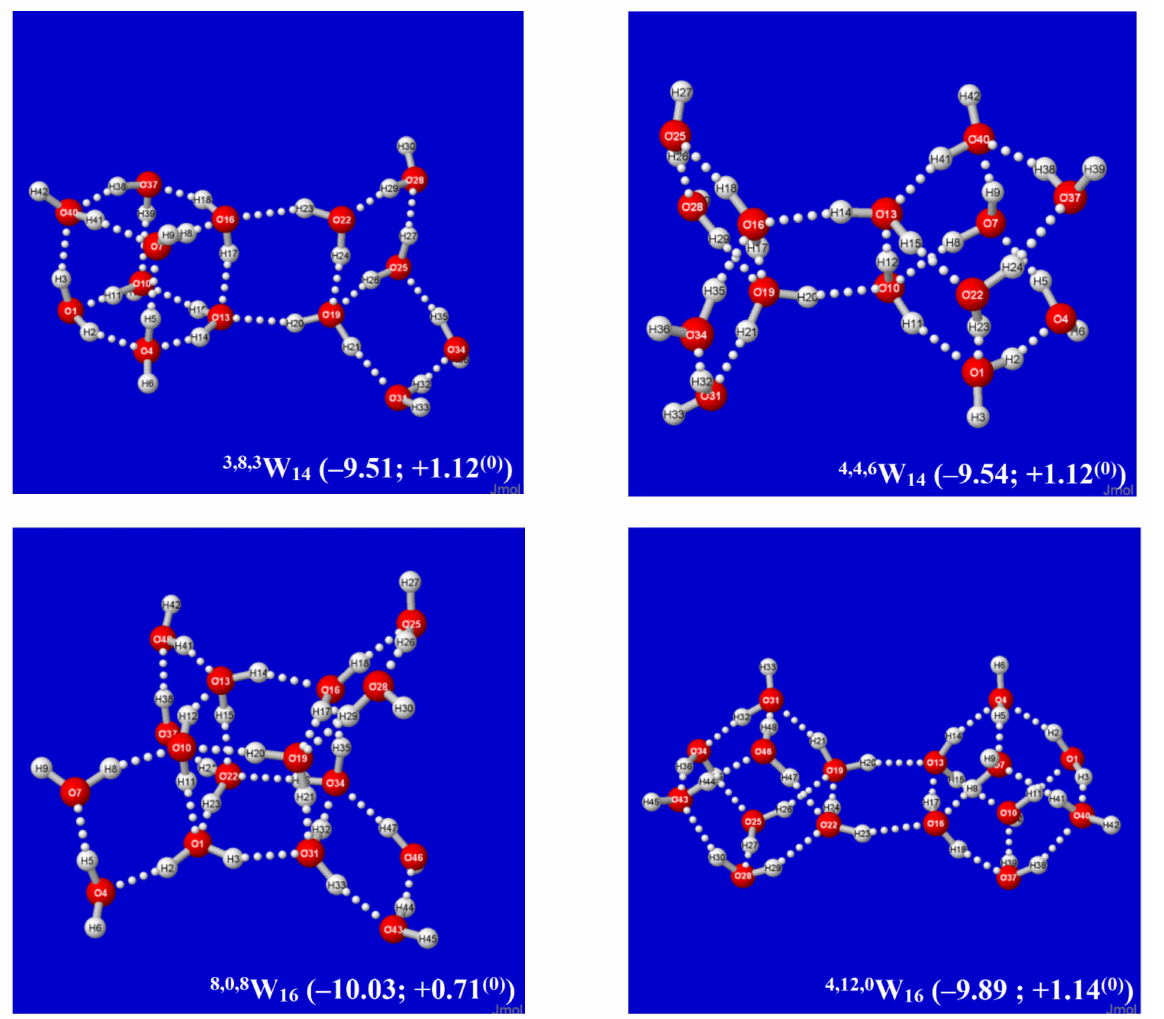
Figure 3. Similar to Figure 2, for successive q,t,d W k windowpane clusters built from the Möbius-like 1,0,6 W 7 cluster ( upper left